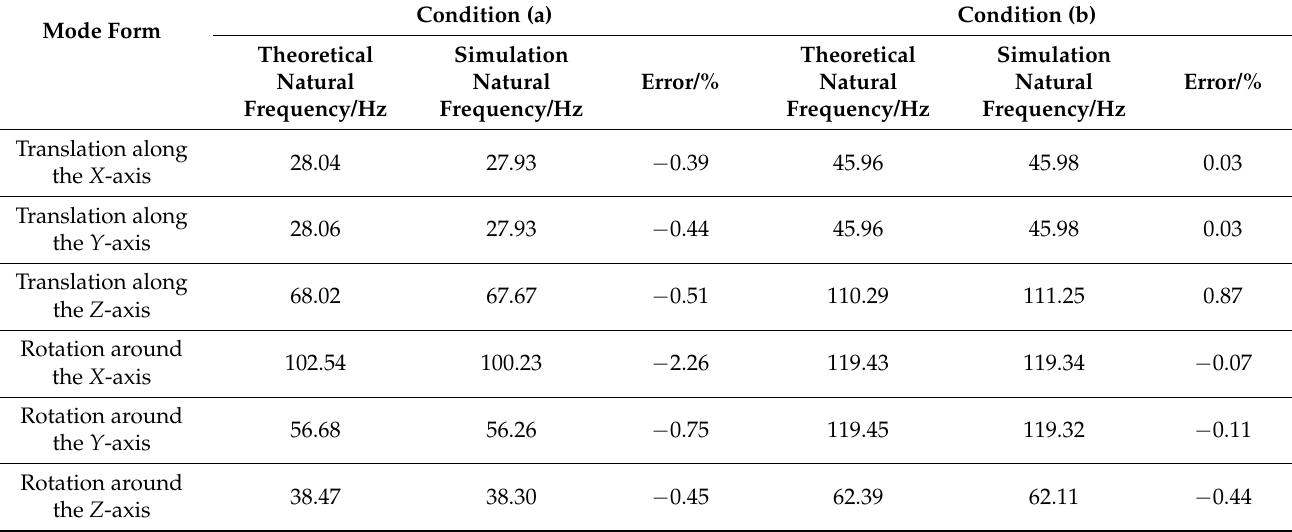
Table 2. Comparison of solved mode of Stewart platform without flexible joints stiffness.